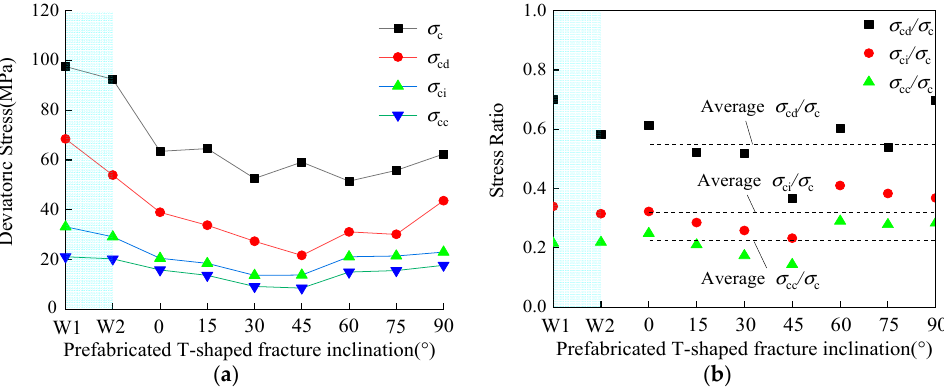
Figure 9. Relationship between the fracture inclination and different thresholds, and the stress ratios of the intact and T-shaped fracture samples: ( a ) relationship between the different thresholds and fracture inclination and ( b ) relationship between the stress ratio and fracture inclination.